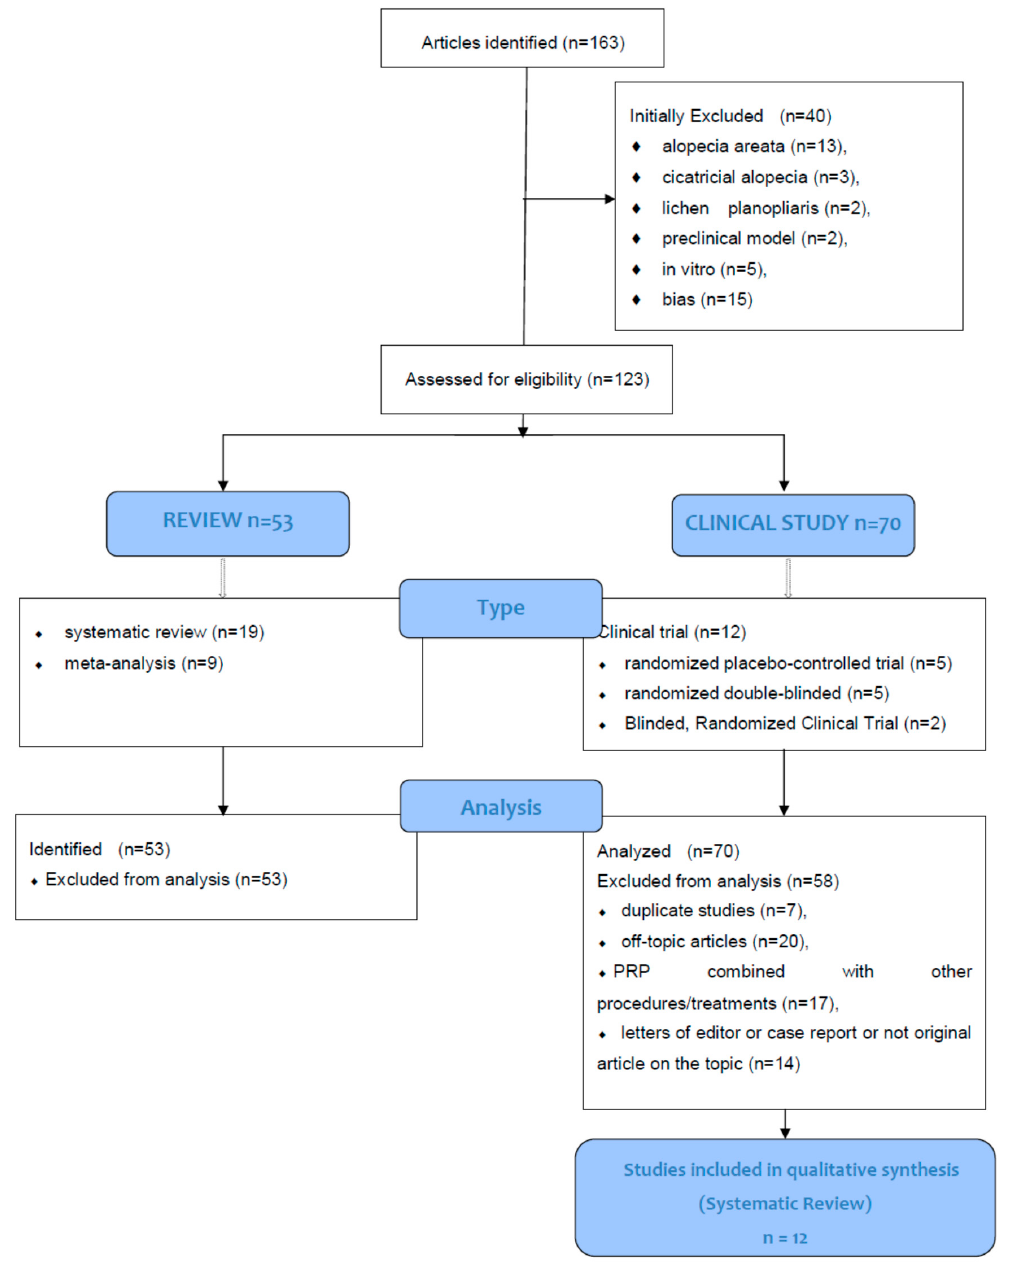
Table 1. The study design and results of the included studies . Abbreviations: M, male; F, female; wks, weeks; mos, months. * p value not